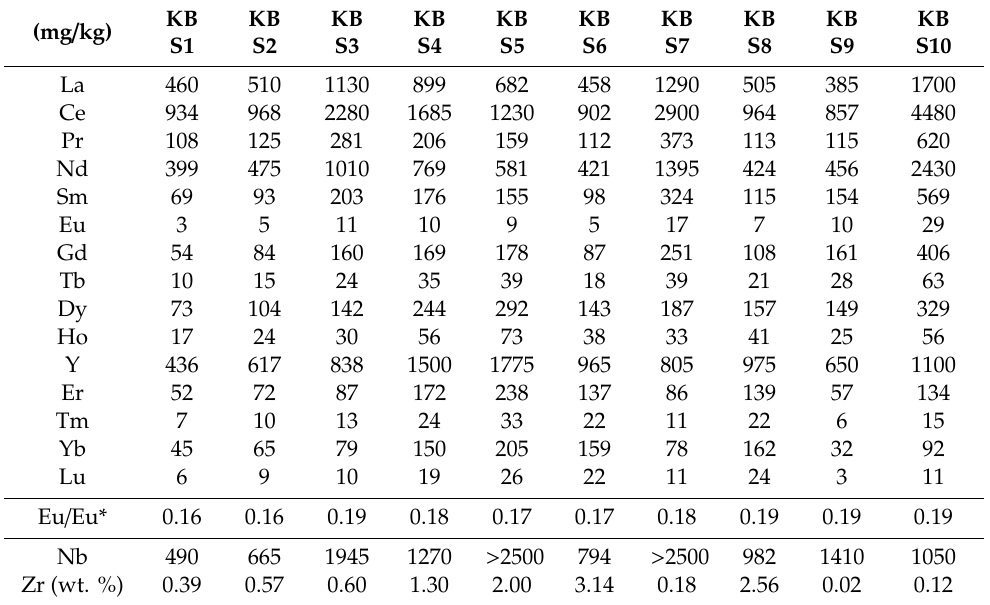
Table 4. REE + Zr and Nb composition of KB S. Zirconium data from handheld XRF measurement. (mg /